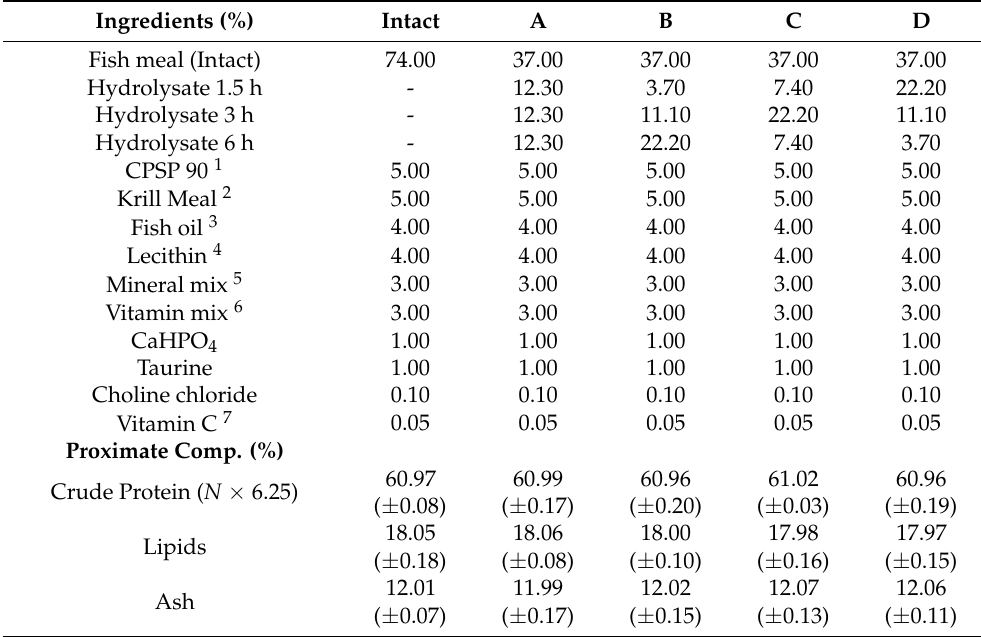
Table 1. Diet formulations for feeding trial.